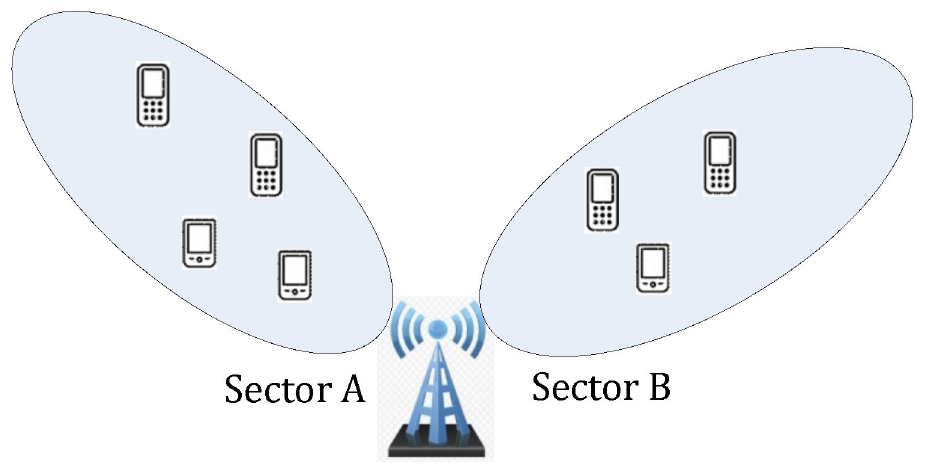
Figure 3. Sectorized BS with two rotational asymmetric